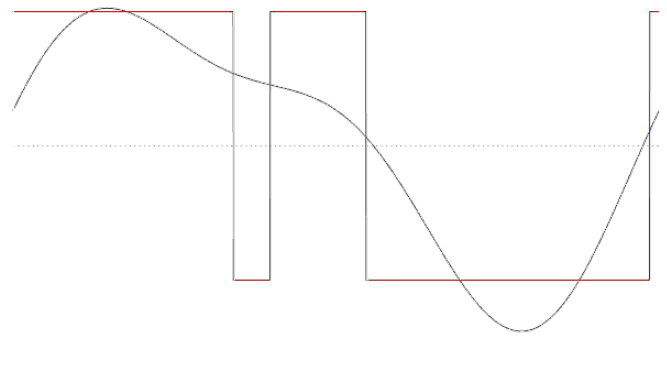
Figure 1. The function sin ( φ ) + sin ( 2 φ ) + cos ( 2 φ ) and the function of the minimum norm (cid:107) · (cid:107) ∞ with the same set of first five Fourier coefficients.